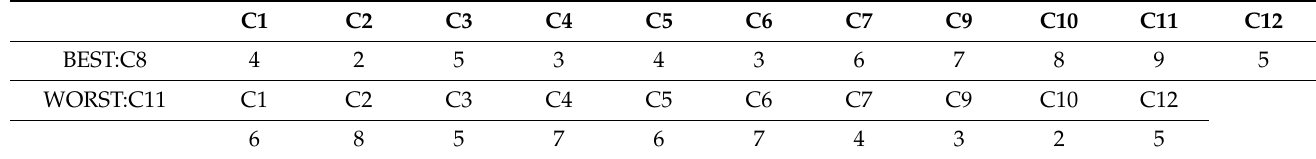
Table 7. Paired comparisons of the criteria with the best and worst